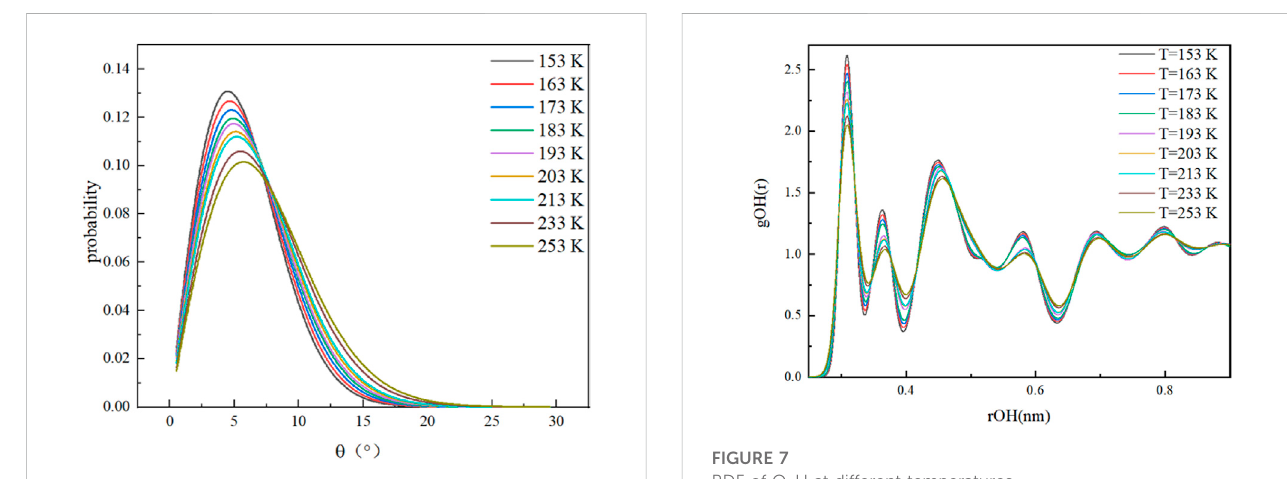
FIGURE 6 Probability distribution of hydrogen bond angles at different temperatures.